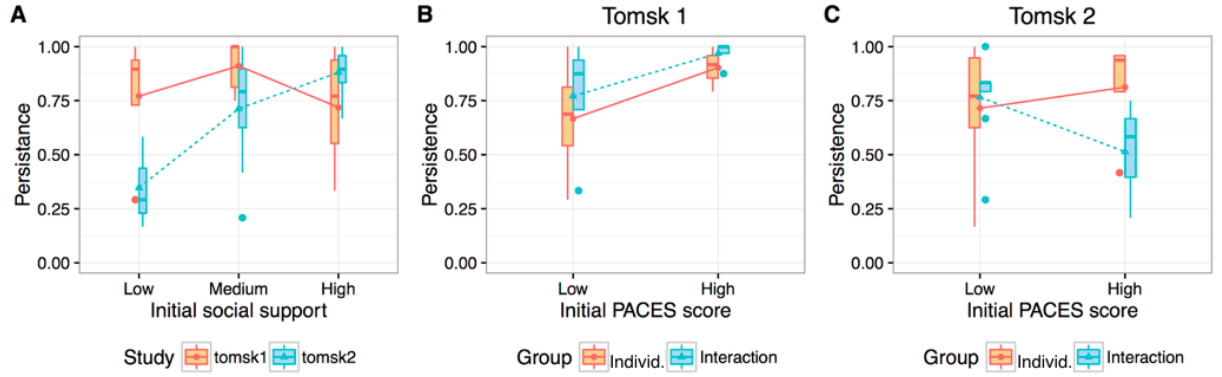
Figure 6. Interaction plots for persistence and baseline measures. (A) Interaction between study and initial level of social support (medical outcomes survey, MOS score has been grouped in three equally distributed intervals: low, medium, and high). (B) Interaction between group and initial PACES score in Tomsk1. (C) Interaction between group and initial PACES score in